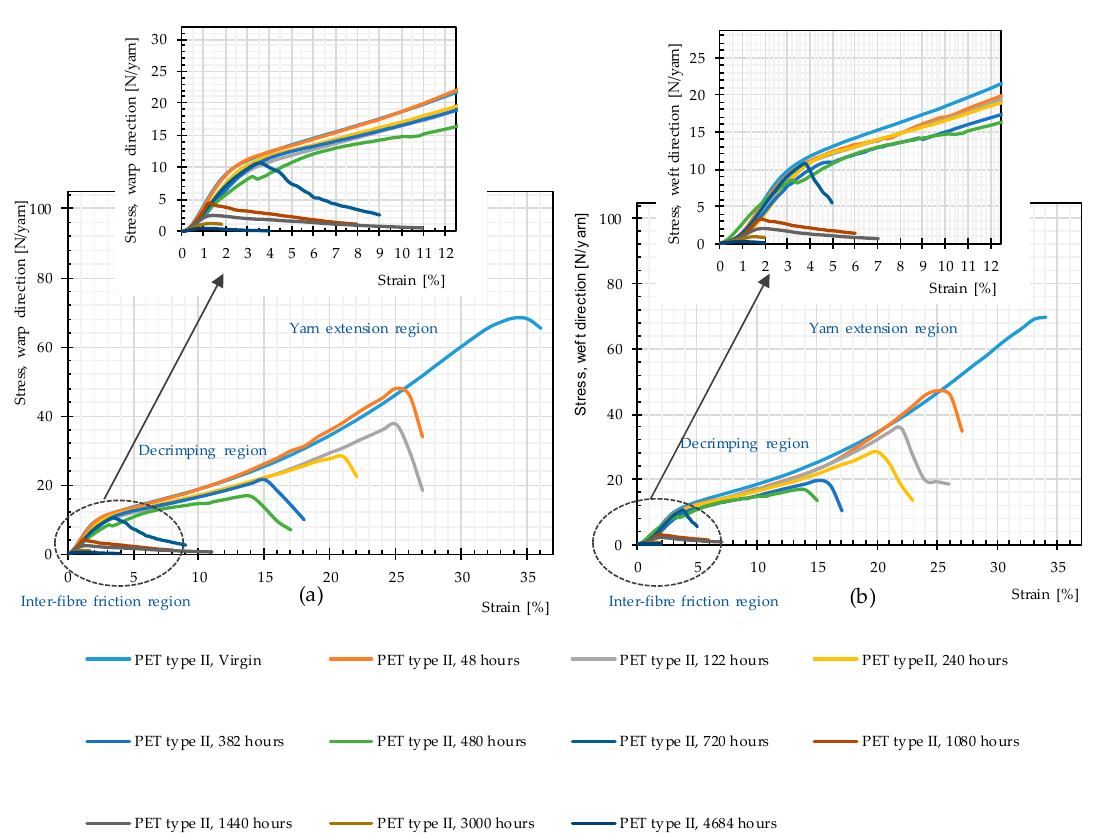
Figure 11. Stress–strain curves, weathering Method M4, different weathering durations, uncoated PET Type II: ( a ) warp direction; and ( b ) weft direction.